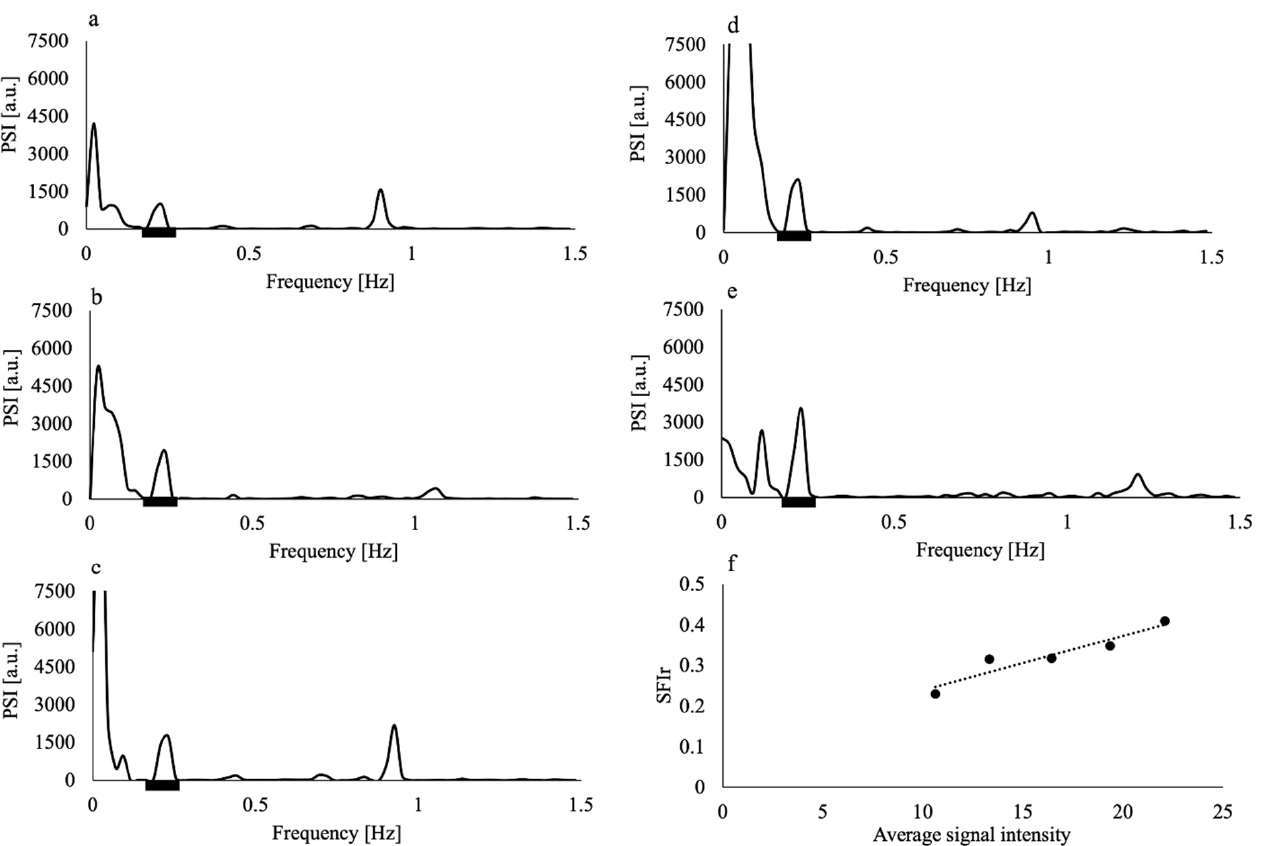
Figure 3. Power spectral intensity (PSI) of the time series MR signal of the superior sagittal sinus from imaging with slice thicknesses of ( a ) 7 mm, ( b ) 9 mm, ( c ) 11 mm, ( d ) 13 mm, and ( e ) 15 mm of a non ‐ smoker volunteer; ( f ) spectral fluctuation intensity at the respiratory frequency (SFIr) versus average signal intensity of the same volunteer. Black thick bars in ( a – e ) represent the respiratory frequency range. Dashed line in ( f ) represents the regression line. The data of this volunteer showed the highest coefficient of determination of the regression line (R 2 = 0.90).